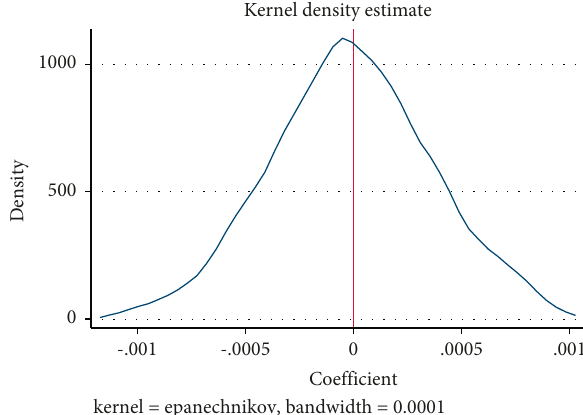
Figure 2: Distribution of 􏽢 α random